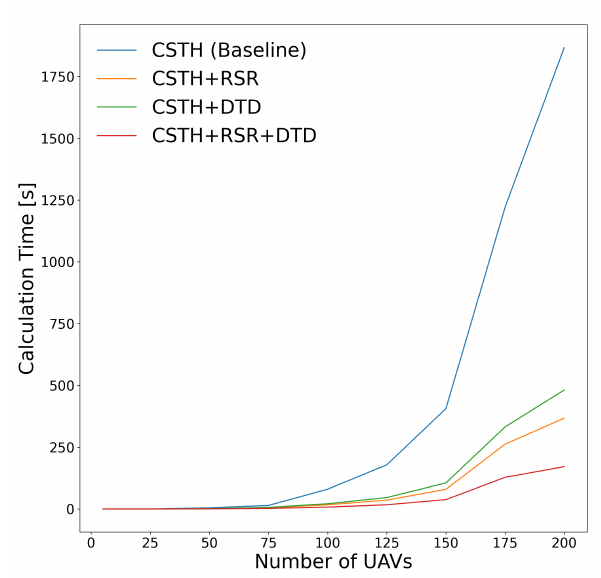
Figure 16. Calculation time for the linear formation when varying the number of UAVs in the swarm.